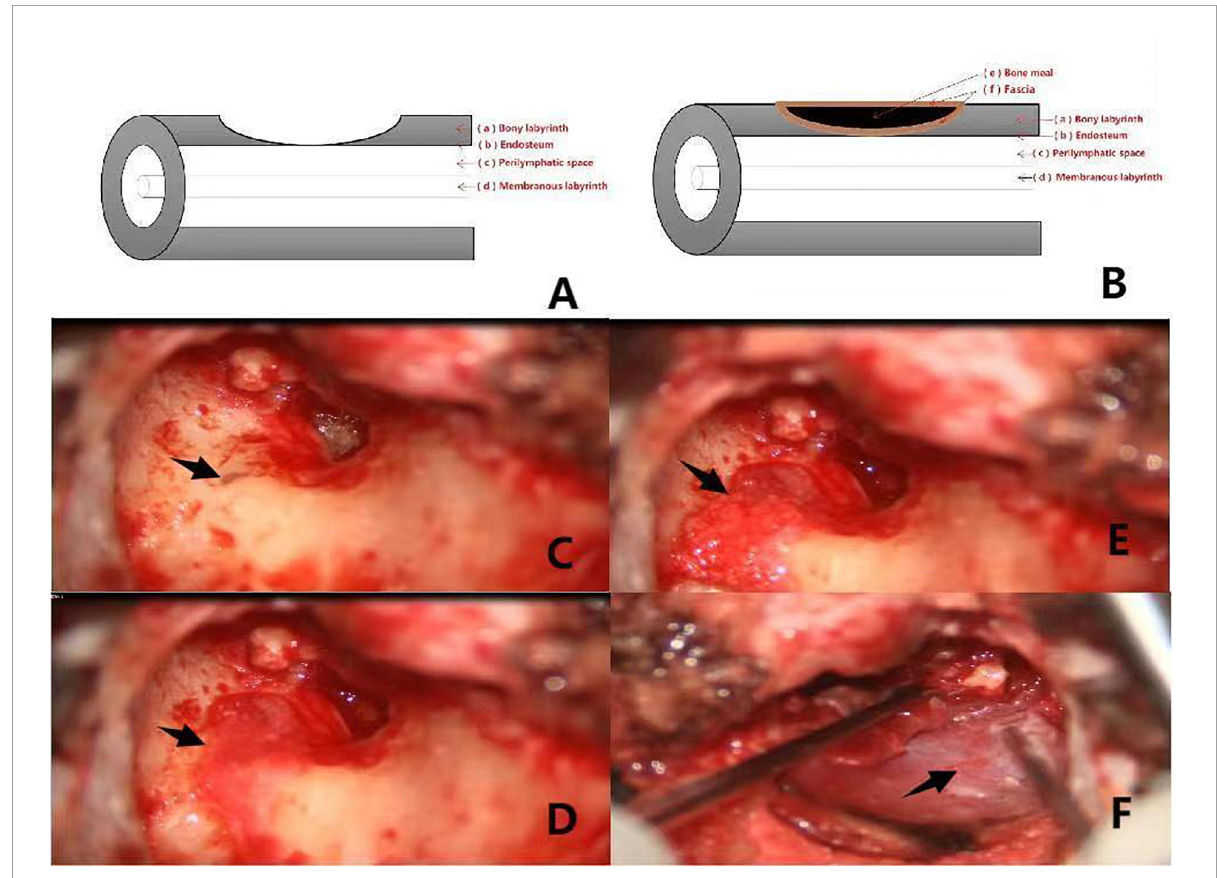
FIGURE1 (A,B) Shows the preoperative and postoperative pattern diagram of a patient with type I labyrinteric fistula. The red arrows (a–f) respectively, represent the bony labyrinth, endosteum, perilymphatic space, membranous labyrinth, bone meal, fascia. Pictures (C–F) are intraoperative of a patient with type I labyrinthine fistula. (C) : Type I labyrinthine fistula with endosteum and cholesteatoma epithelium covered with surface (the black arrow). (D) : Fascia placed on the surface of the fistula (the black arrow). (E) : Surface of the fascia with clean bone meal (the black arrow). (F) : Fascia placed on the surface of the bone meal (the black